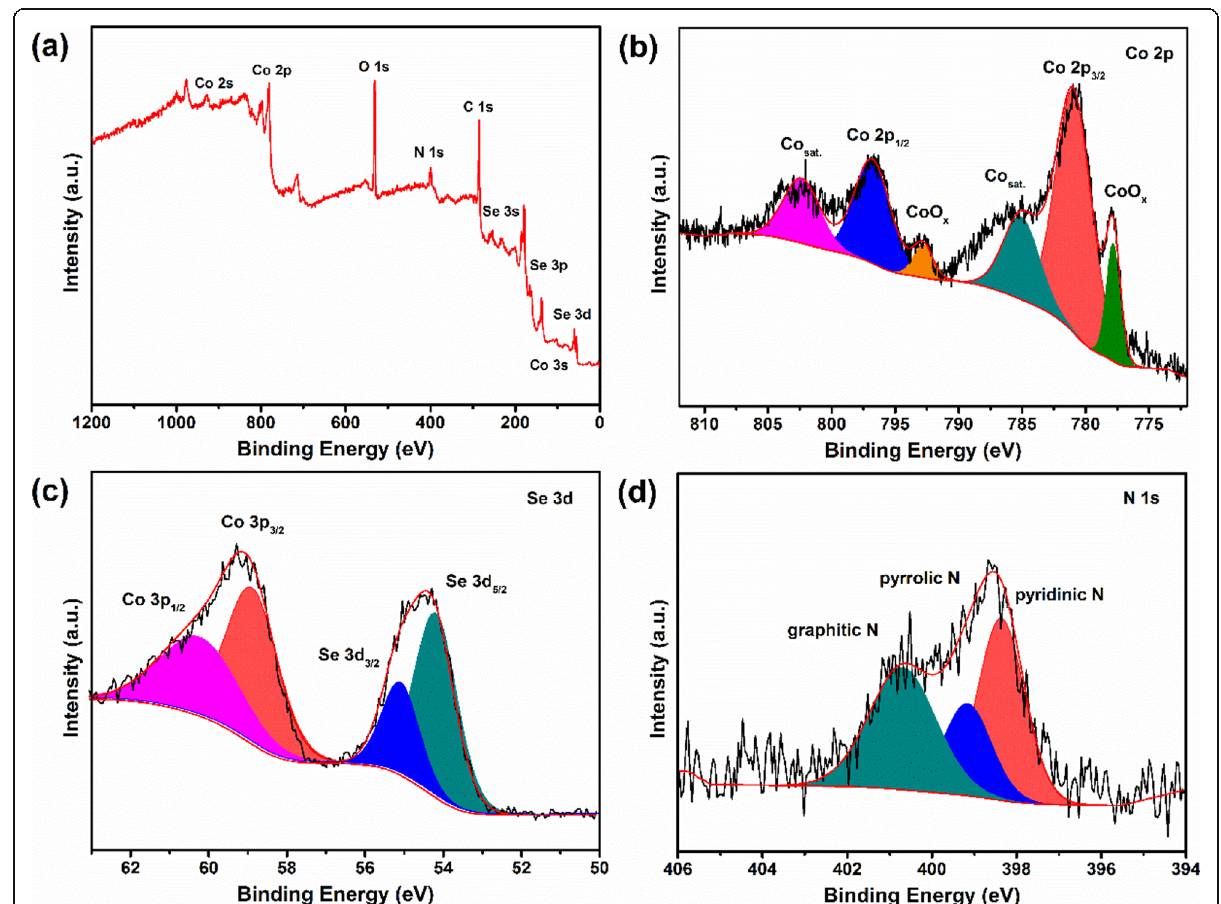
Fig. 4 XPS spectrums of CoSe/NC: a survey, b Co 2p, c Se 3d, and d N 1s